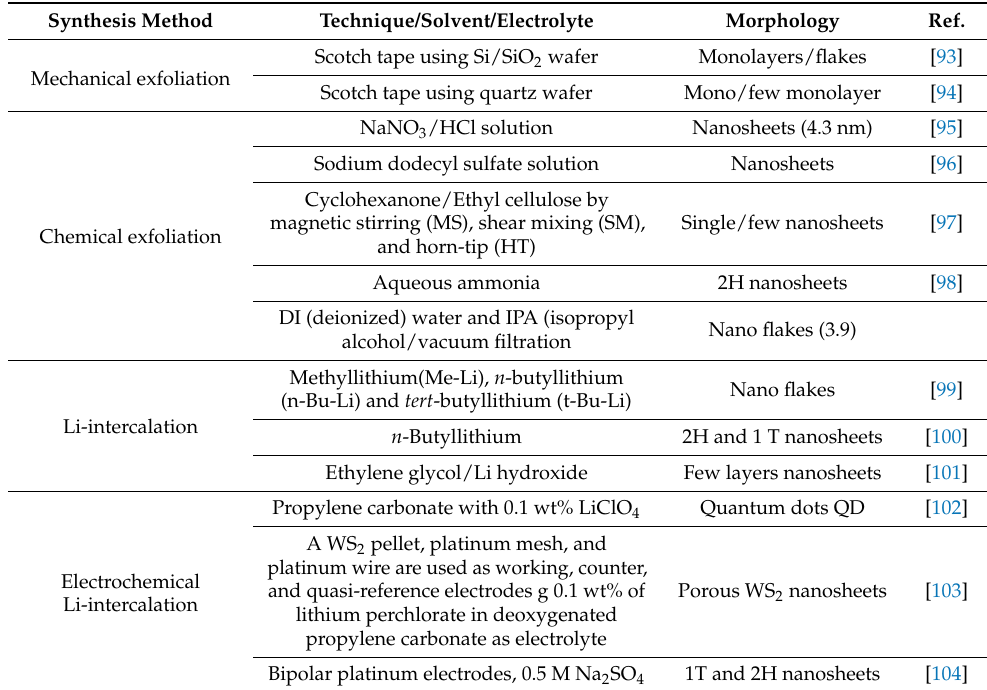
Table 2. Summary of the exfoliation method conditions and achieved WS 2